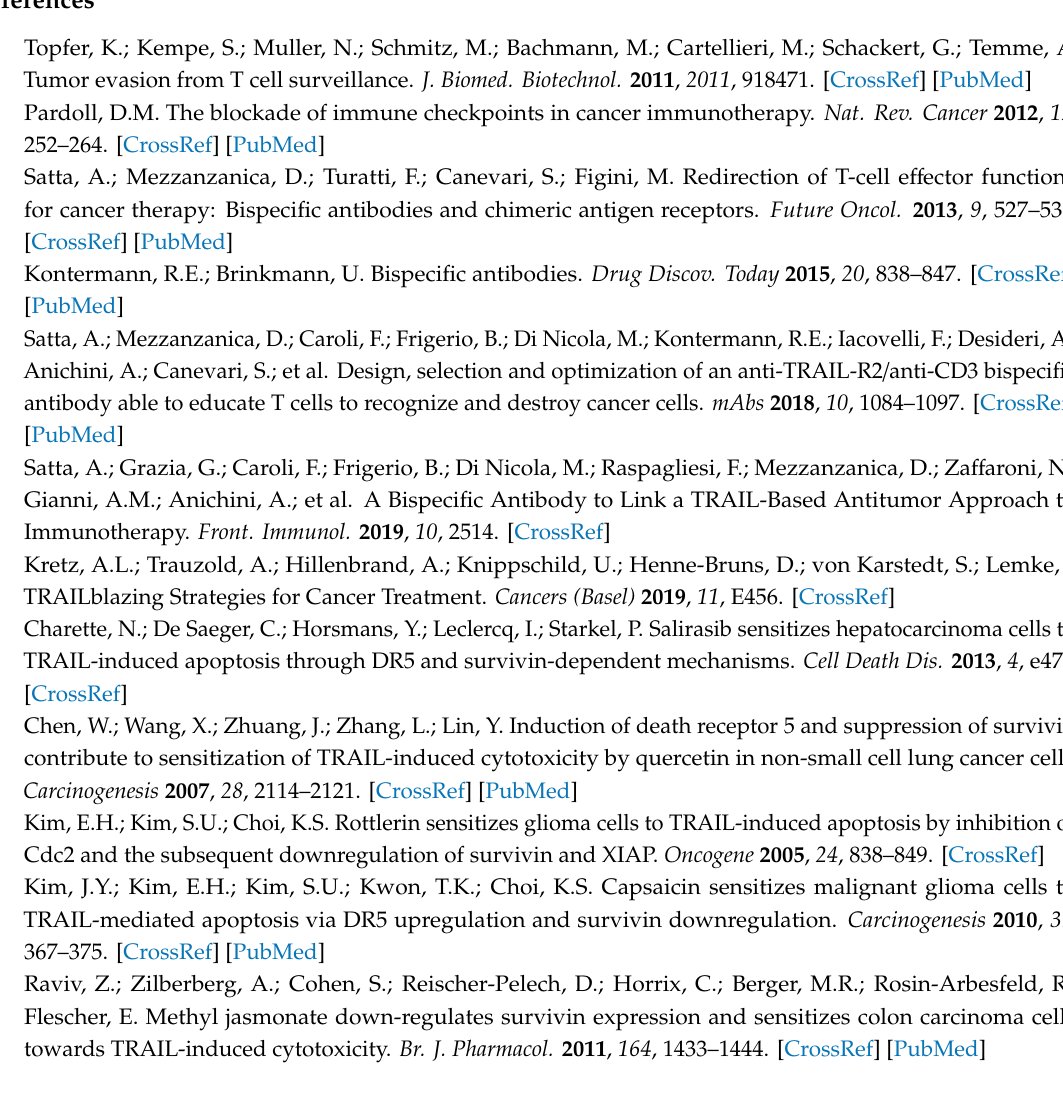
Figure S1: TRAIL-R2 expression of TNBC cell lines. Figure S2: cytotoxic experiment containing PBLs alone, BsAb alone and selinexor + PBLs controls. Table S1: Concentrations of selinexor required to inhibit cell growth